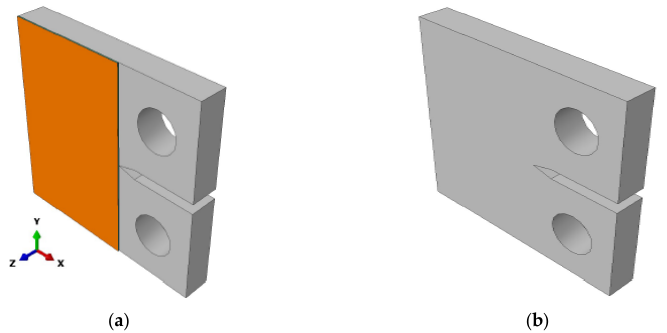
Figure 5. Numerical models: ( a ) Strengthened compact tension (CT) specimen; ( b ) Plain steel CT specimen.